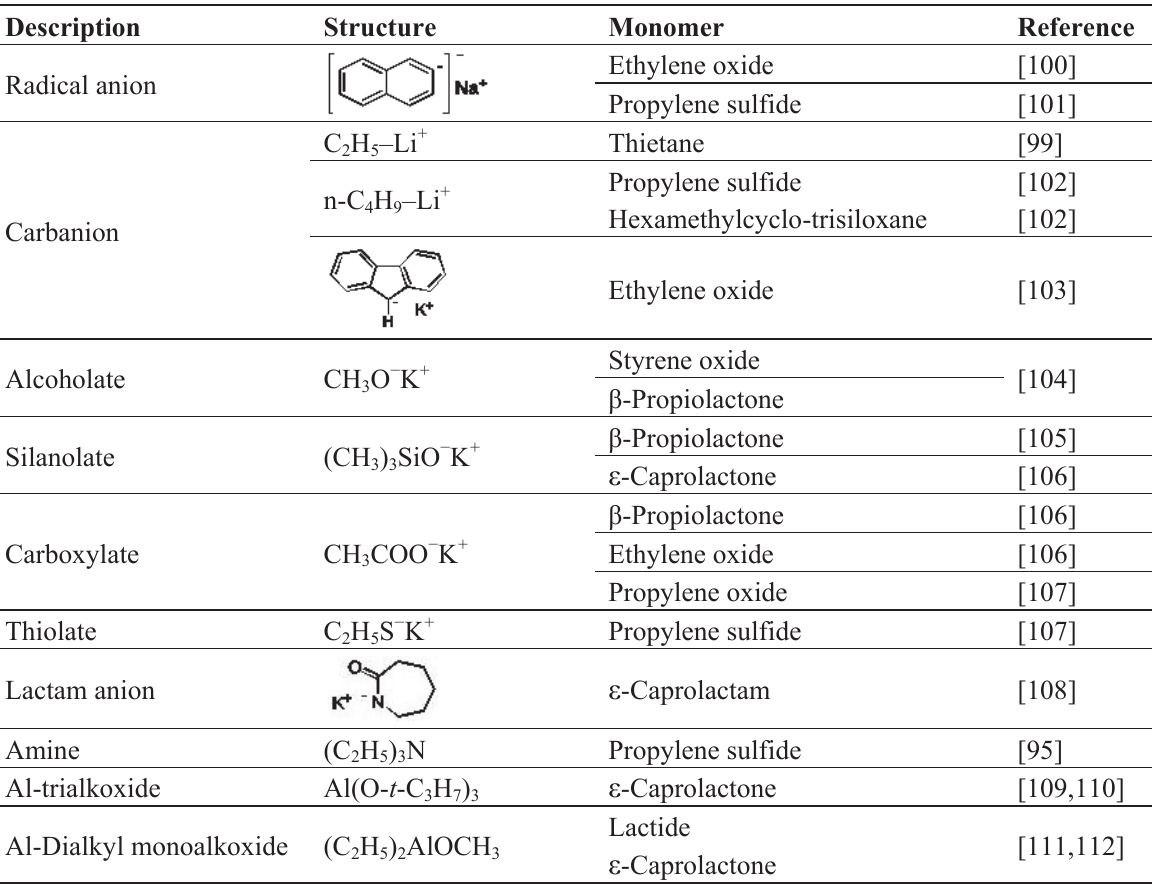
Table 4. Initiators for an AROP of heterocycles.